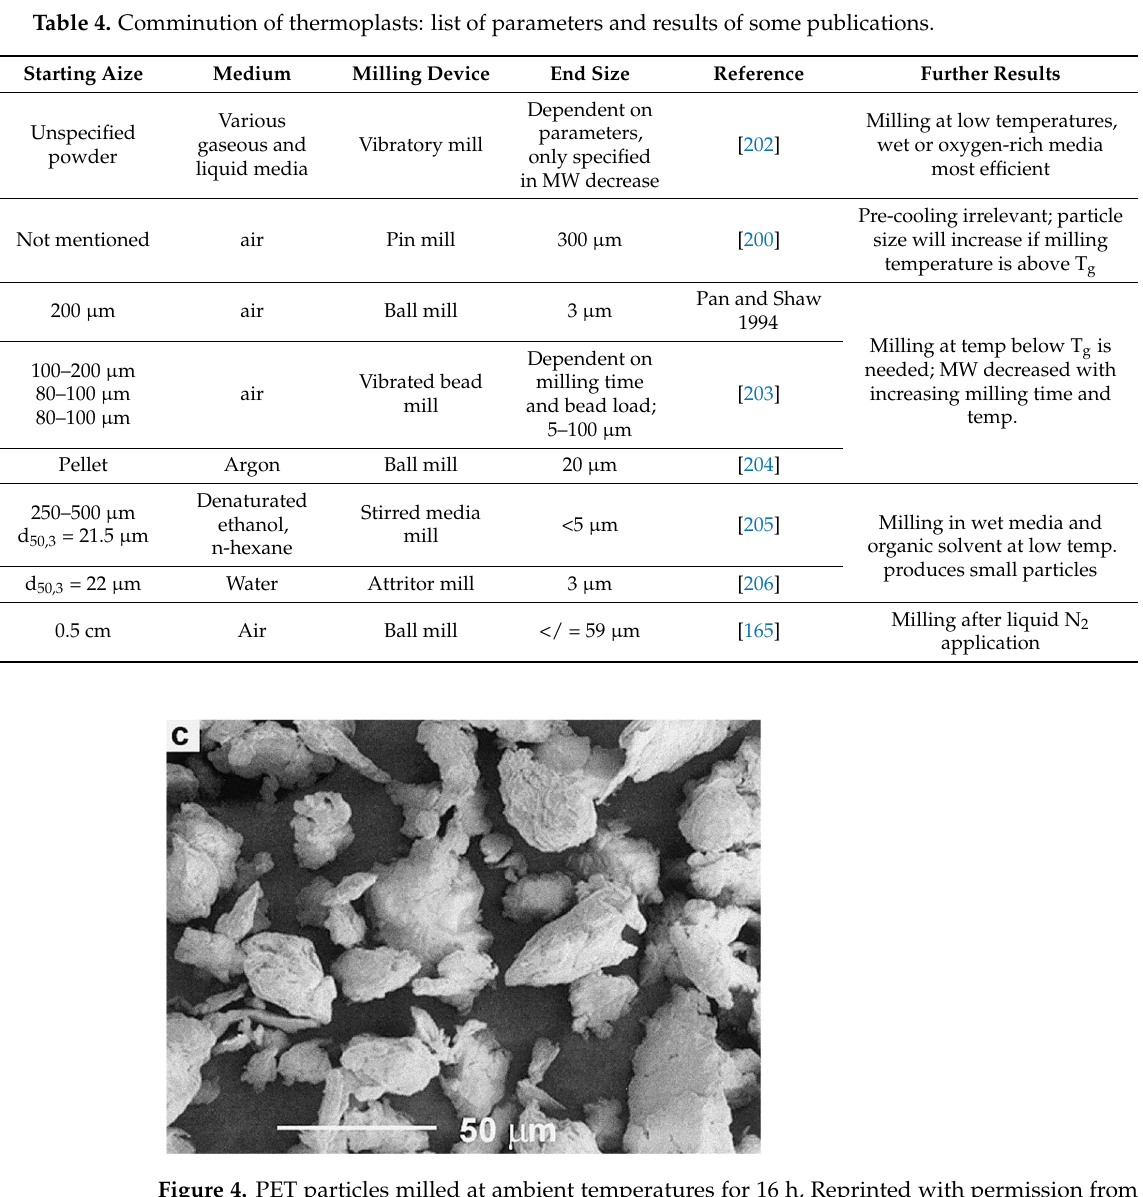
15 of 26 Table 4. Comminution of thermoplasts: list of parameters and results of some publications. Material